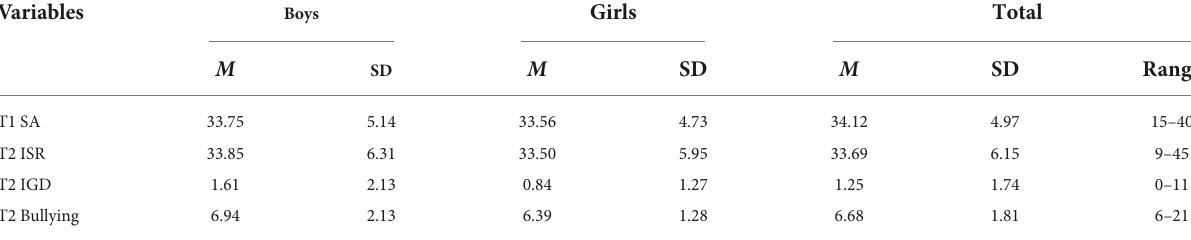
TABLE 1 Descriptive statistics of key variables.